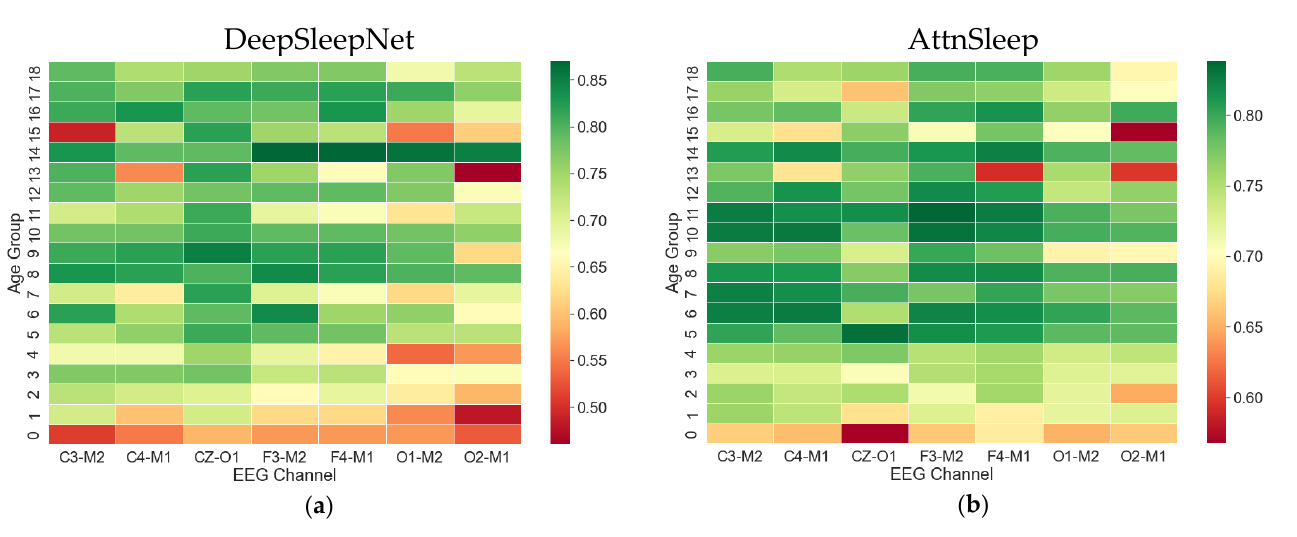
Figure 5. Heatmap of the WF1 scores of each channel over different age groups for ( a ) DeepSleepNet and ( b ) AttnSleep. In AttnSleep, F3-M2 and F4-M1 outperformed other channels in participants > 5 years old. In DeepSleepNet, CZ-O1 was superior in most age ranges.